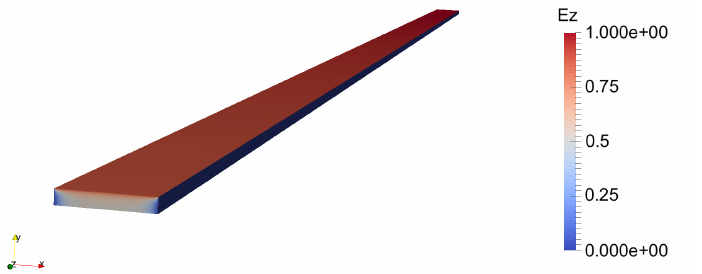
Figure 5. Through-the-thickness-simulated electric field when the incident field is polarized in the normal direction with respect to the fibers for ω 2 = 24.5 GHz.